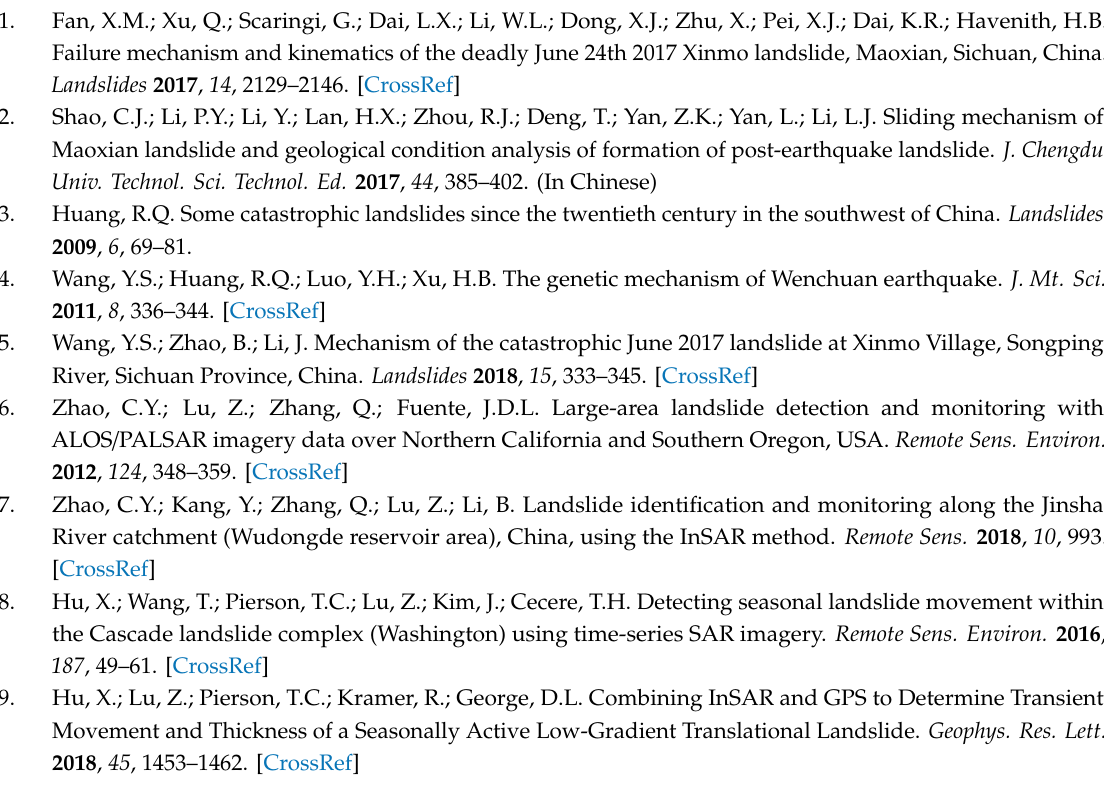
Figure S1: Time-series deformation from Sentinel-1, where one color period represents 4 π and the background is the digital elevation model (DEM). Figure S2: Time-series deformation from Envisat, where one color period represents 3 π and the background is